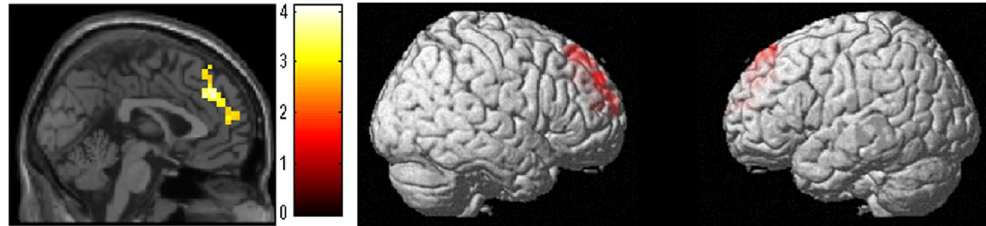
Figure 3. Larger increases in fractional amplitudes of low-frequency fluctuations (fALFF) in the working memory training (WMT) group compared with the control group. Results are shown with a threshold of P < 0.05 and were corrected for multiple comparisons at the cluster size with an underlying uncorrected voxel- level of P < 0.005. These data show that compared with the no intervention (control) group, WMT resulted in significant increases in fALFF in the anatomical cluster that spread mainly from the right superior frontal gyrus, to the dorsomedial prefrontal cortex, the supplementary motor area, and the frontopolar